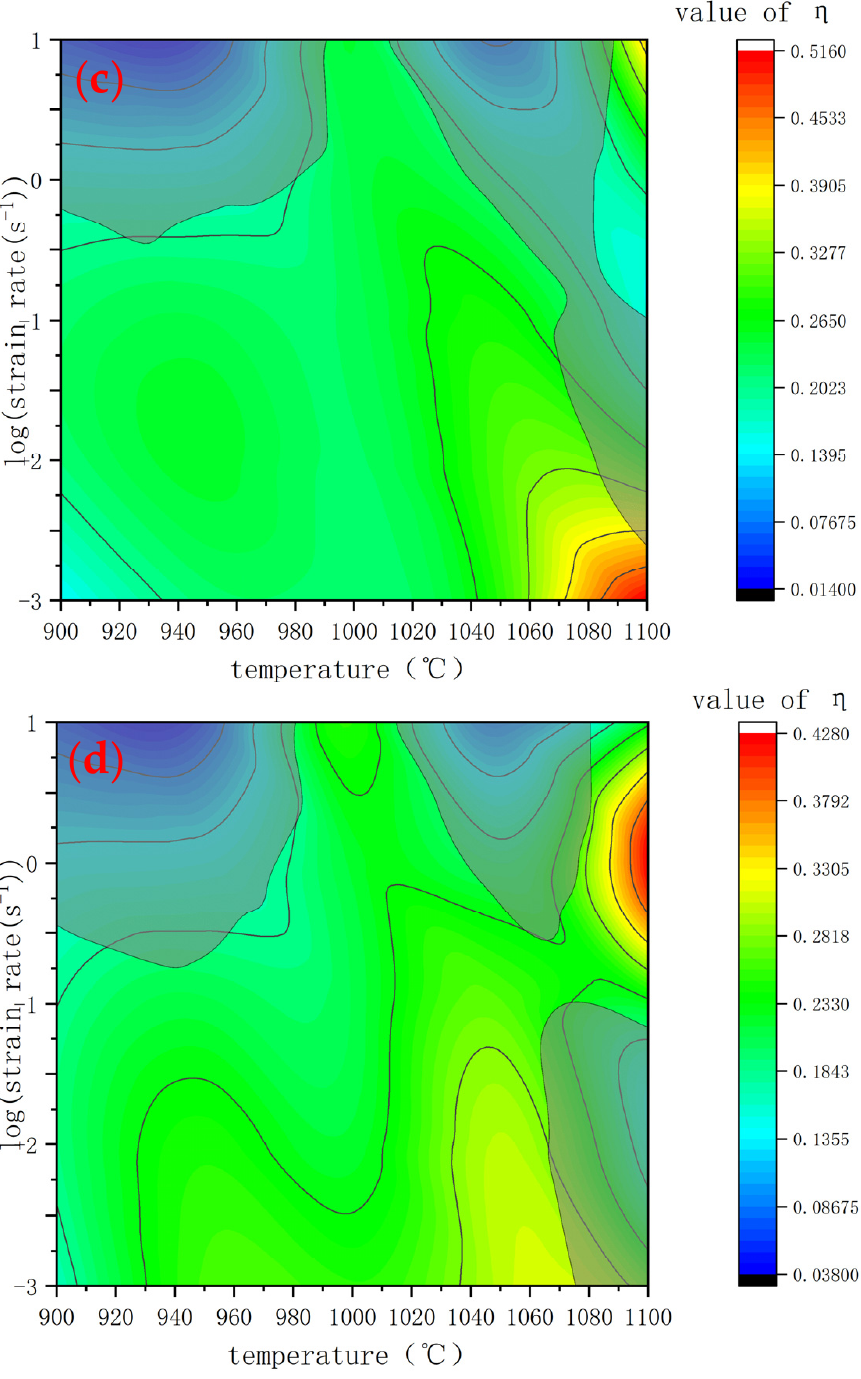
Figure 7. Thermal processing chart under different true strains: ( a ) 0.1, ( b ) 0.2, ( c ) 0.3, and ( d ) 0.4. Figure 8 shows optical microstructures at different deformation rates when the defor- mation temperature is 1050 ◦ C. The strain rate has a significant effect on the grain size. The grain size decreases when the strain rate is from 0.001 s − 1 to 10 s − 1 . As shown in Figure 8a, the grain size is coarse at the strain rate of 0.001. At this case, the deformation time is longer, and the microstructure recovery is more sufficient. Therefore, there are coarse grains in the microstructure. With the increase of the strain rate, the grain size gradually decreases (Figure 8b–e). This can be attributed to the dynamic recovery and recrystallization